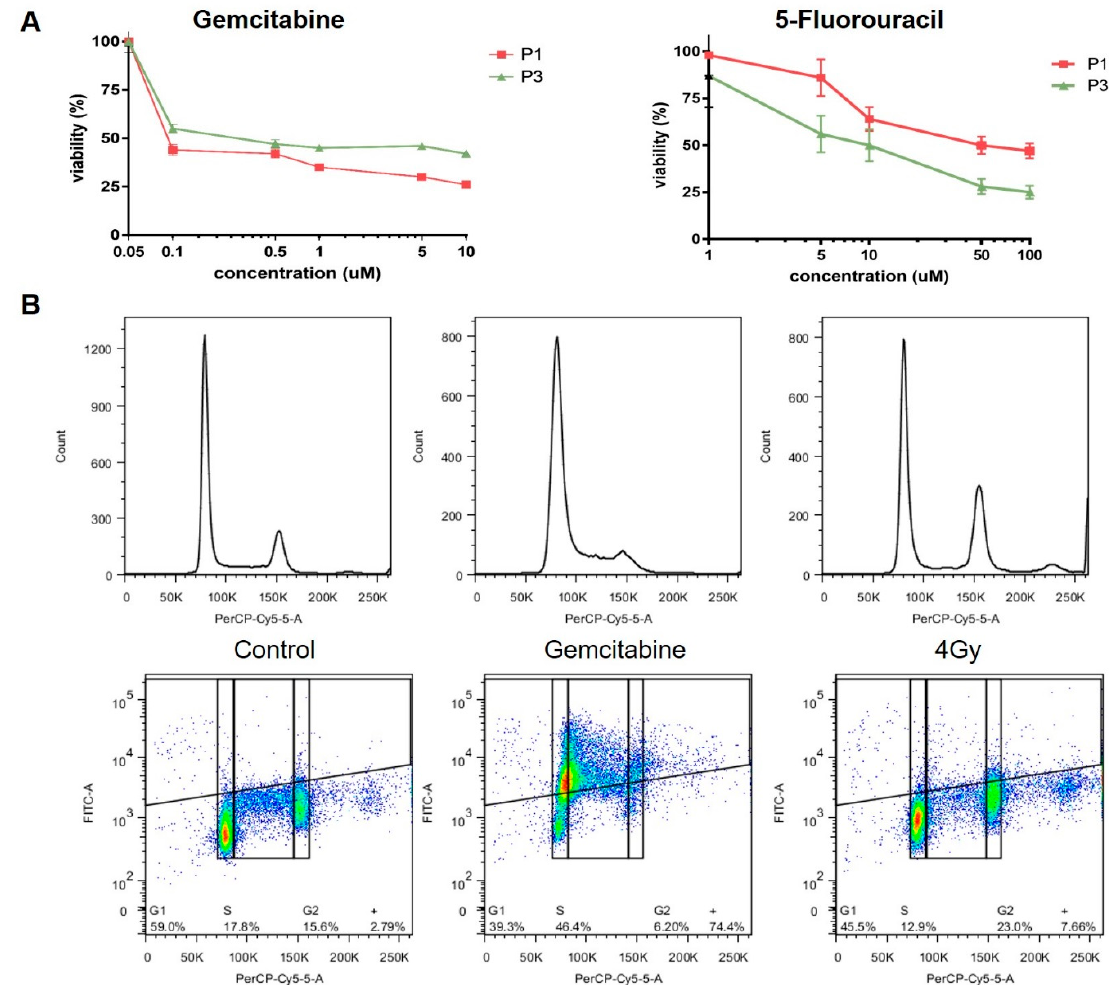
Figure 6. Treatment response of CTC cultures to chemotherapy. Response to treatment with ( A ) gemcitabine, 5FU and ( B ) IR was evaluated using Water Soluble Tetrazolium (WST) assays and flow cytometry, respectively.